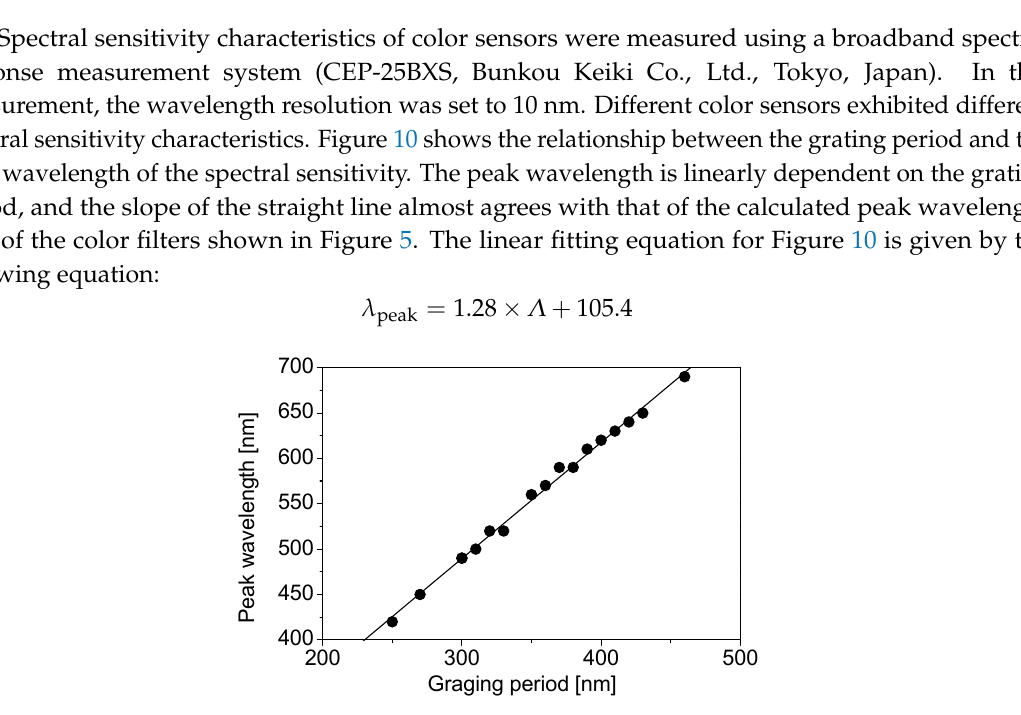
Figure 12. Dependence of the peak wavelengths of reconstructed spectra on the center wavelength of the incident monochromatic lights. 6. Conclusions We fabricated a filter array spectroscope consisting of metamaterial color filters and Si photodiodes. The color filters based on guided-mode resonant metal gratings were newly designed. The peak wavelength of the transmission spectrum could be controlled mainly by the grating period. The filters were fabricated in 25 patterns, with grating periods between 220 and 460 nm at increments of 10 nm. SEM images of fabricated color filters confirmed that all the filters were fabricated accurately. The peak wavelength of the spectral sensitivity was found to be linearly dependent on the grating period. Several monochromatic lights were made incident on the fabricated device and the spectral characteristics of the incident light were reconstructed from the output signals obtained from the respective color sensors. The peak wavelengths of the reconstructed spectra were in good agreement with the center wavelengths of the monochromatic lights. Author Contributions: Conceptualization, Y.K.; methodology, Y.K.; software, D.E.; validation, Y.K., D.E. and K.H.; formal analysis, Y.K. and D.E.; investigation, Y.K., D.E. and K.H.; resources, Y.K., D.E. and K.H.; data curation, D.E. and Y.K.; writing—original draft preparation, Y.K.; writing—review and editing, Y.K.; visualization, D.E. and Y.K.; supervision, K.H.; project administration, Y.K.; funding acquisition, Y.K. Funding: A part of this research was funded by the MEXT KAKENHI 16K13648 and 16H04342. 400